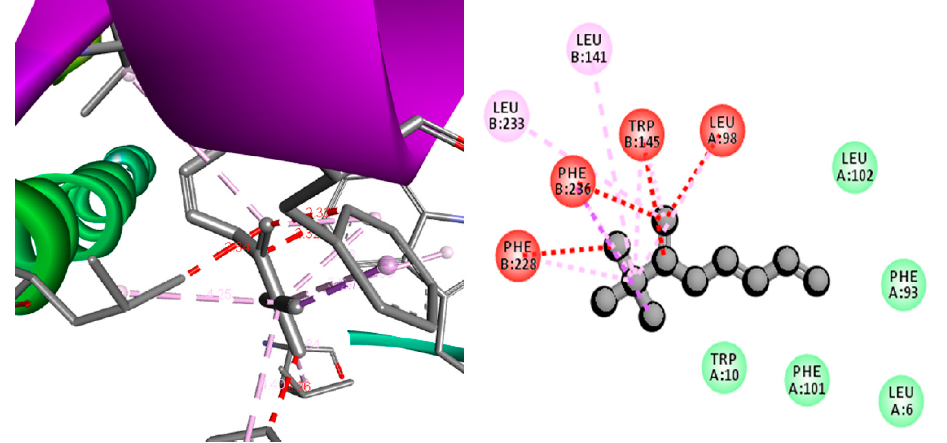
Figure 5. 3D and 2D docking pose showing the interactions between compounds 2,3,3-trimethyl-octane and anti-pro apoptotic protein survivin (1F3H).